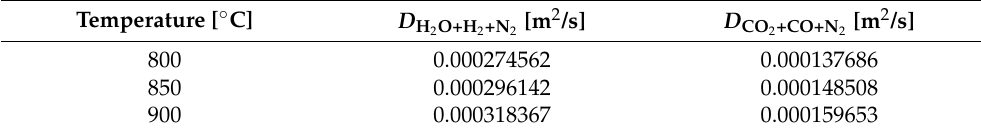
Table 2. Diffusion coefficients of gas